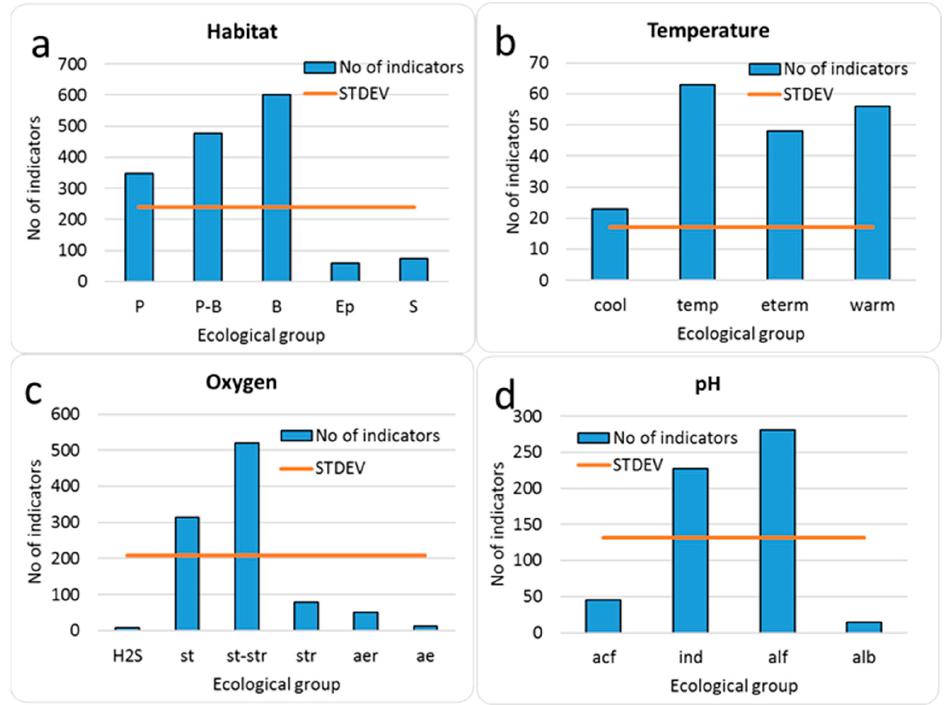
Figure 2. Distribution of species-indicator in groups of preferences of habitat: (P—planktonic, P-B—plankto-benthic, B—benthic, Ep—epiphyte, S—soil) ( a ). Temperature: (cool—cool